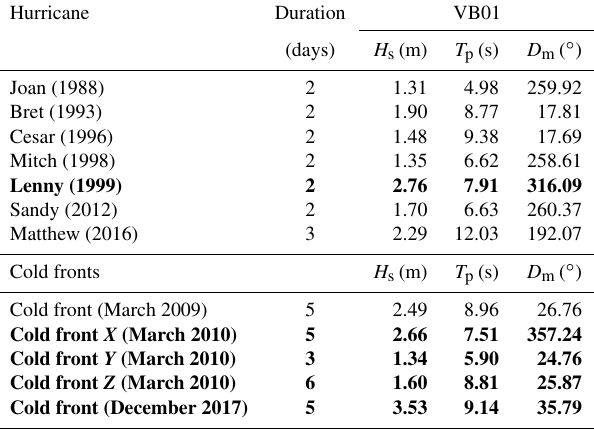
Table 1. Analyzed storms from VB01 (Bocagrande) wave series. Duration over the studied area, maximum significant wave height ( H s ), peak period ( T p ) and mean direction ( D m ) are displayed. Se- lected events are shown in bold